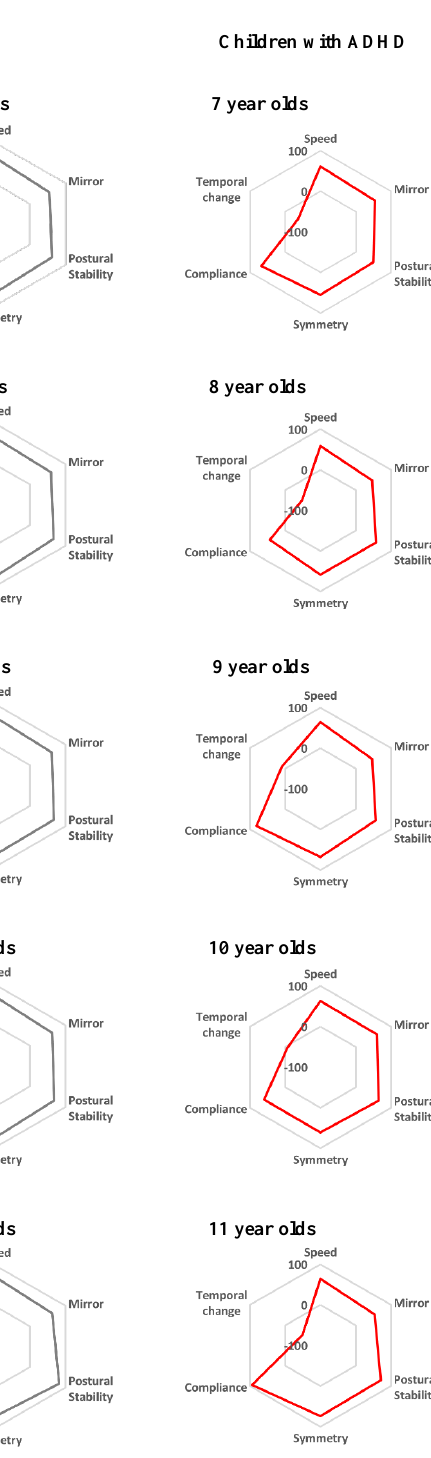
Figure 4. The comparison of function’s balance between TD children and children with ADHD in pronation and supination. Speed, Rotational speed; Mirror, Mirror movement; Postural stability, Postural stability of elbow; Symmetry, Bimanual symmetry; Temporal change, Temporal change of rotational size. Gray radar charts show the data of TD children. Red radar charts show the results for children with